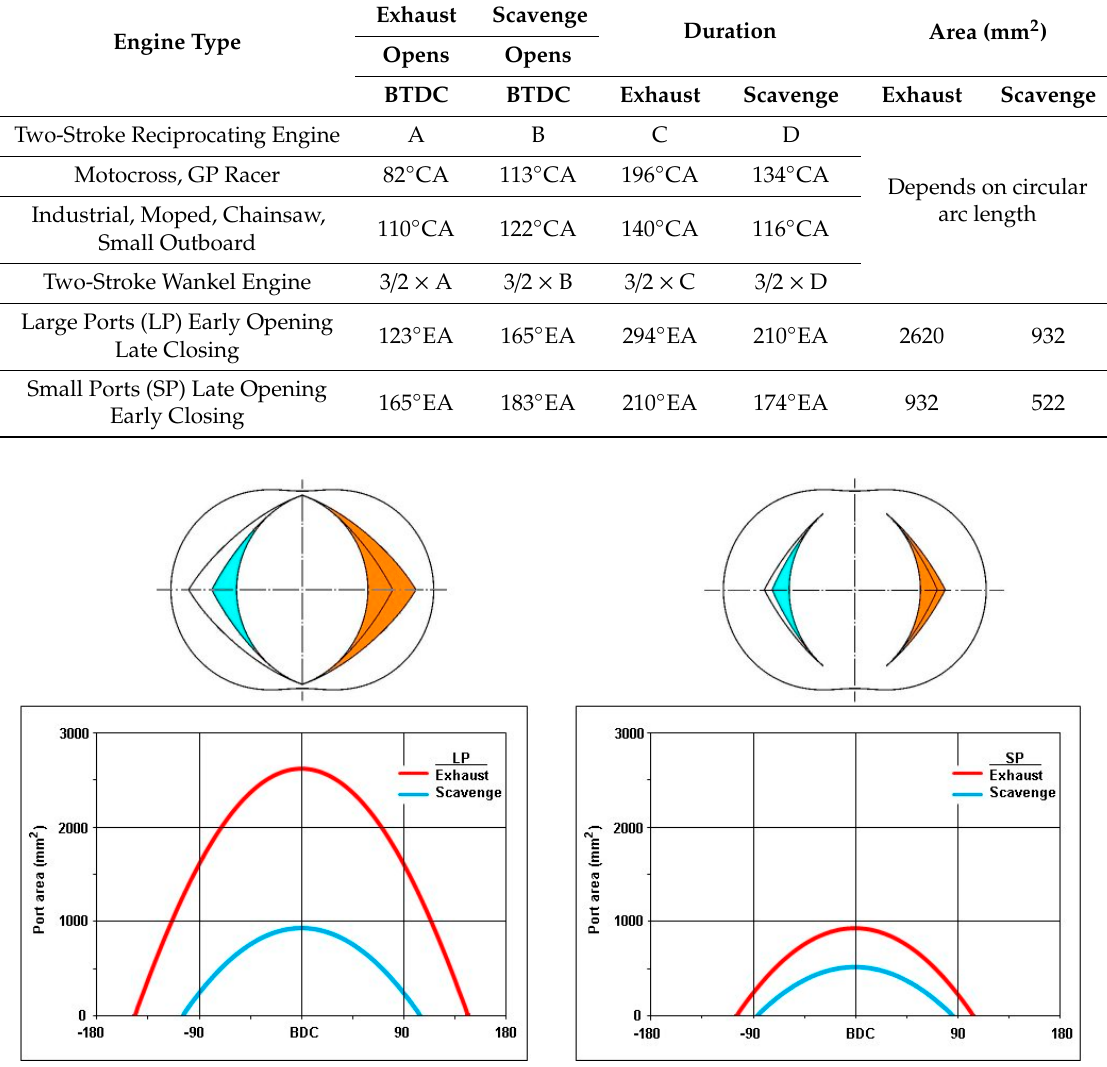
Figure 5. Two-stroke Wankel engine configuration with large and small port (LP and SP) areas.